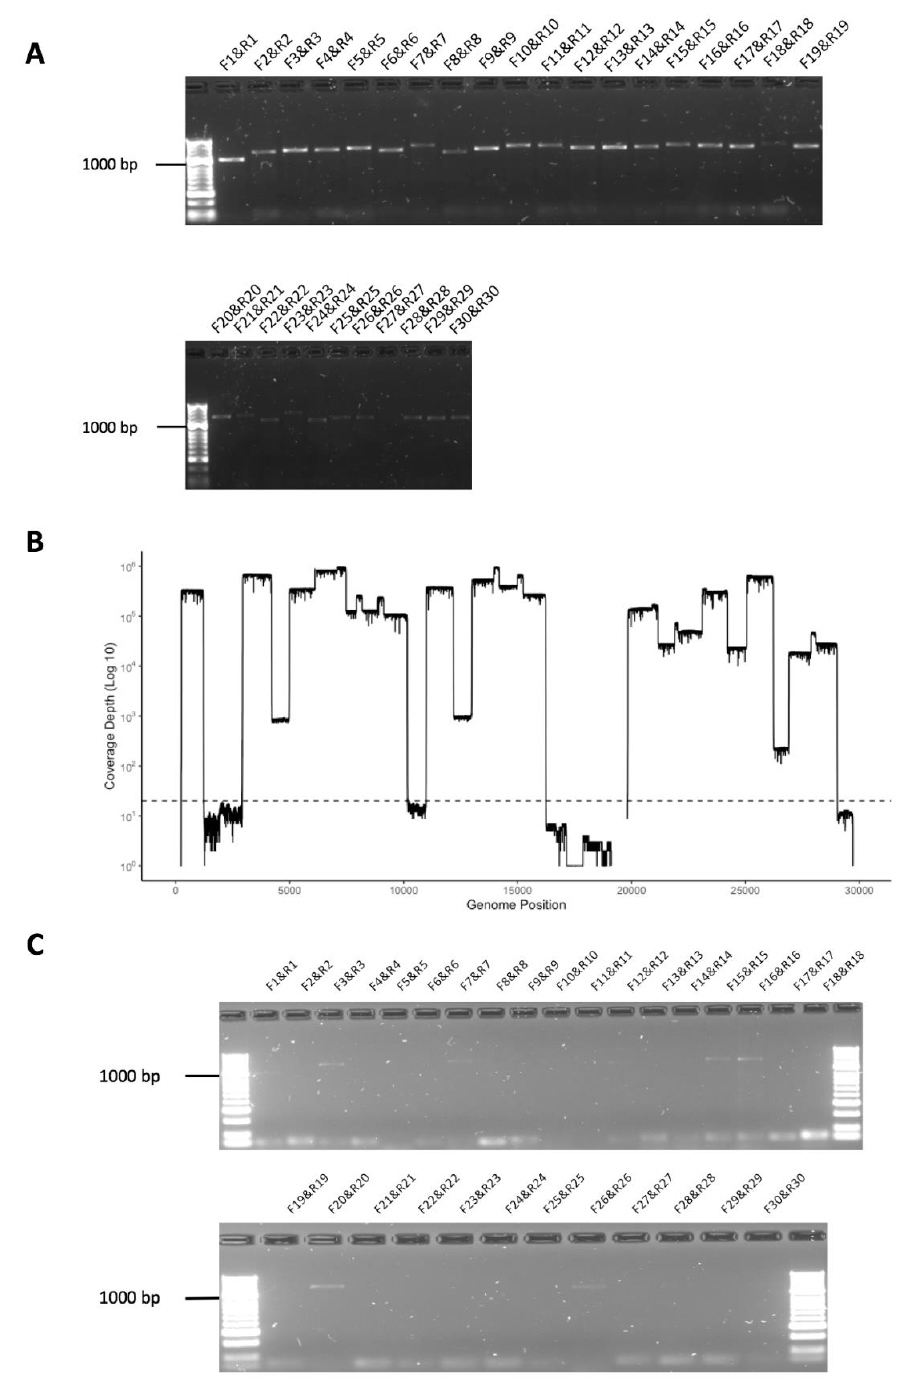
Figure 2. ( A ) Agarose gel electrophoresis analysis of amplicons generated by RT-PCR from RNA isolated from a nasopharyngeal swab taken from patient REMRQ0001, who had coronavirus disease 2019 (COVID-19), and diagnosed positive for SARS-CoV-2 by a laboratory-based test. Primer pairs are indicated above each amplicon. ( B ) The amplicon products were purified and sequenced on a single flow cell using an Oxford Nanopore MinION. Shown are the number of reads that map ( y -axis) to each amplicon across the SARS-CoV-2 genome from 5′ to 3′ ( x -axis). ( C ) Agarose gel electrophoresis analysis of amplicons generated by RT-PCR from RNA isolated from a nasopharyngeal swab taken from patient REMRQ0001, who had COVID-19, and subsequently found negative for SARS-CoV-2 by a laboratory-based test. Note that the brightness of the image has been adjusted post-image capture to more clearly show amplicon